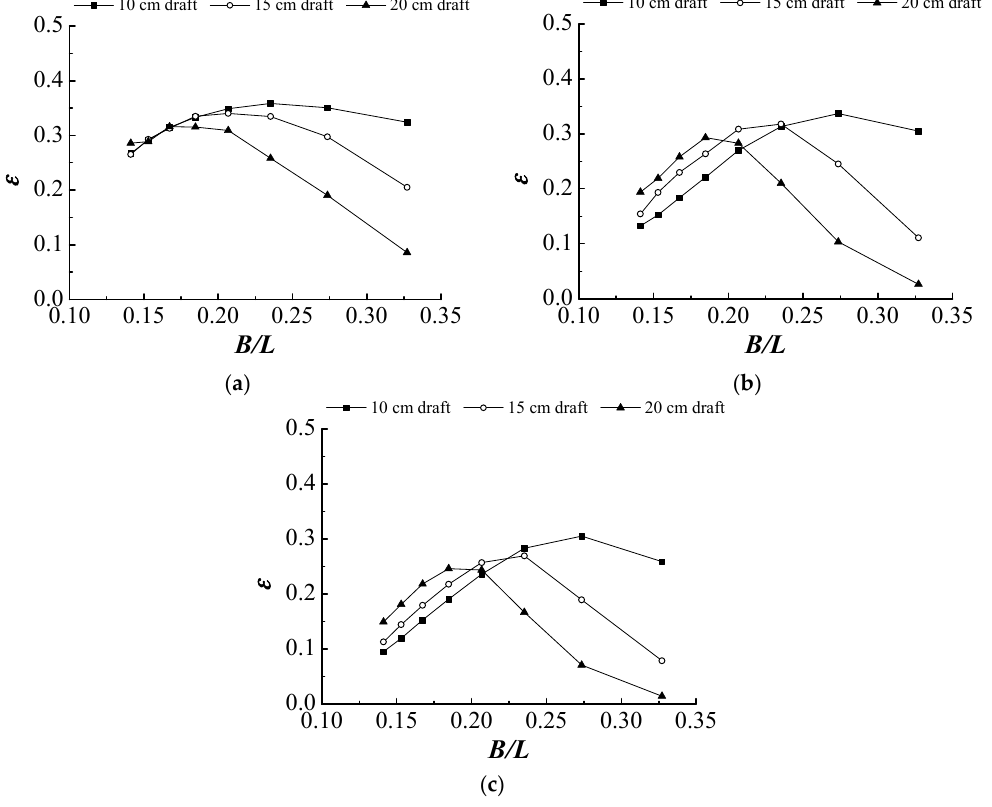
Figure 6. Variations of energy efficiency ε versus B / L with three tested OWC drafts for: ( a ) Slot-shaped opening of 0.625% ratio; ( b ) Slot-shaped opening of 1.25% ratio; ( c ) Slot-shaped opening of 1.875%